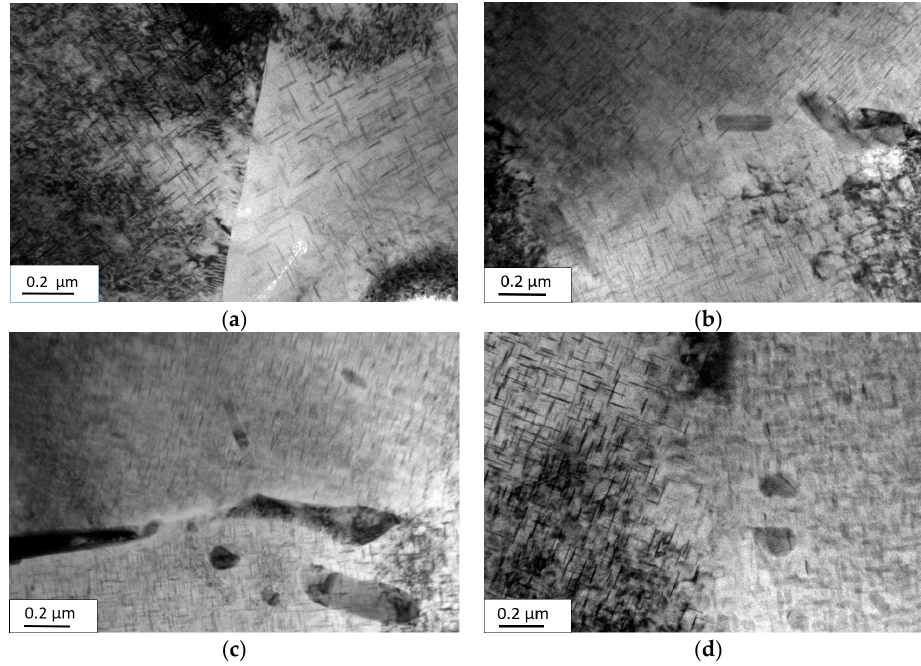
Figure 3 Grain-boundary TEM photo of 2219 aluminum alloy with or without EPC under stress relaxation aging: ( a , c ) conventional stress relaxation aging of 150 and 210 MPa; ( b , d ) electric pulse stress relaxation aging of 150 and 210 MPa.